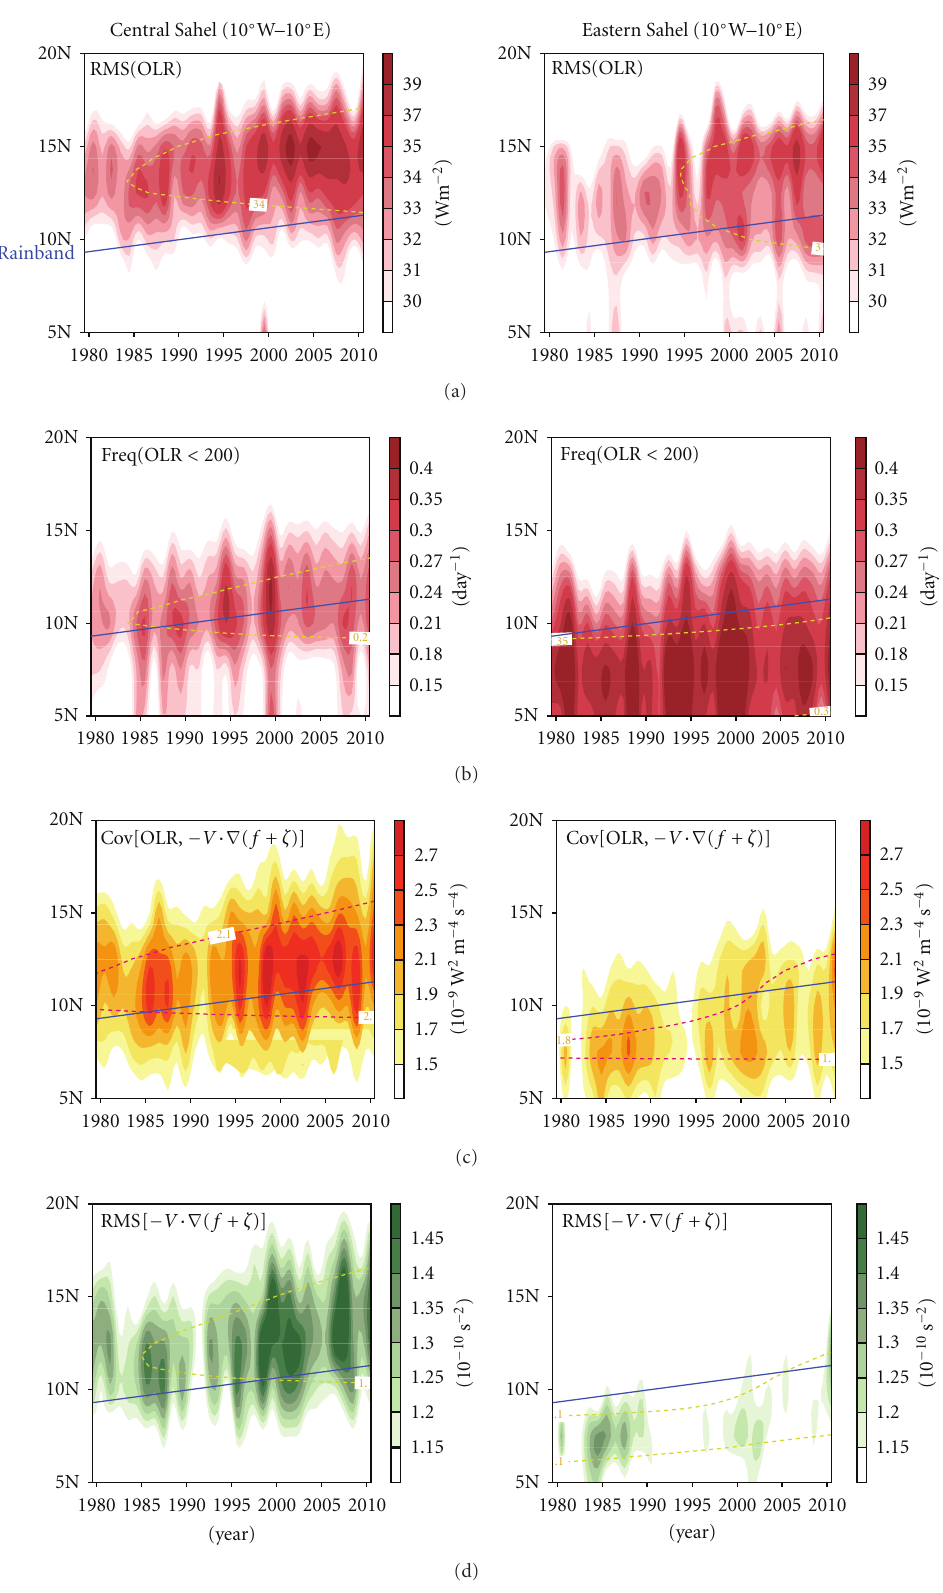
Figure 5: The same as Figure 4 but for (a) root mean square (RMS) of the 2–8 day bandpass filtered OLR, (b) frequency of the OLR values lower than 200 Wm − 2 , (c) covariance of the filtered OLR with horizontal vorticity advection at 600 mb, and (d) RMS of the filtered horizontal vorticity advection at 600 mb. Dashed lines are linear trends of the designated value. The Sahel rainband is indicated by solid blue